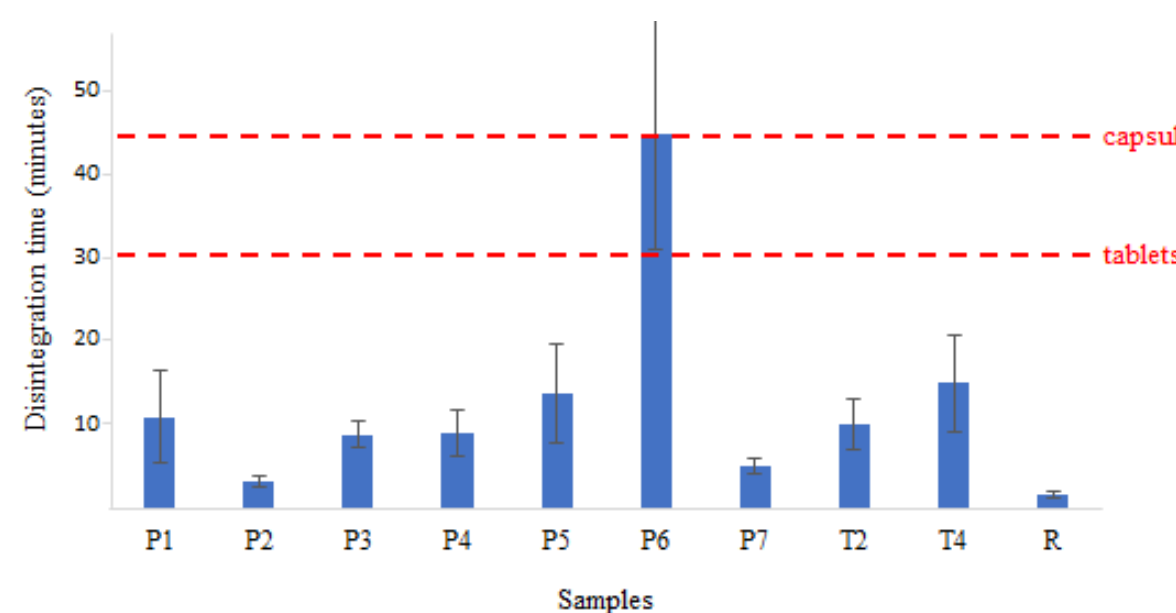
FIGURE 2 - Mean (n = 6) disintegration time for the capsules (P1, P2, P3, P4, P5, P6, P7, T2 and T4) and tablets (R). Dashed lines represent the maximum time allowed by the Brazilian Pharmacopoeia for the dissolution of 40 mg tablets (30 minutes) and capsules (45 minutes) of